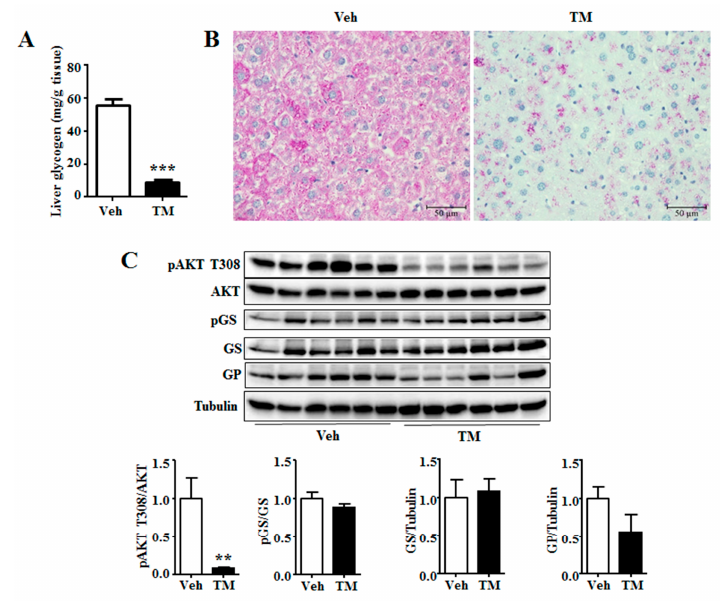
Figure 6. Tunicamycin decreased hepatic glycogen content. ( A ) Hepatic glycogen content; ( B ) PAS staining of liver; ( C ) Western blotting bands and quantification of liver proteins. N = 6 per group. Scale bars were equal to 50 μ m. Veh, vehcle; TM, tunicamycin. ** p < 0.01, *** p < 0.001 TM vs. Veh.